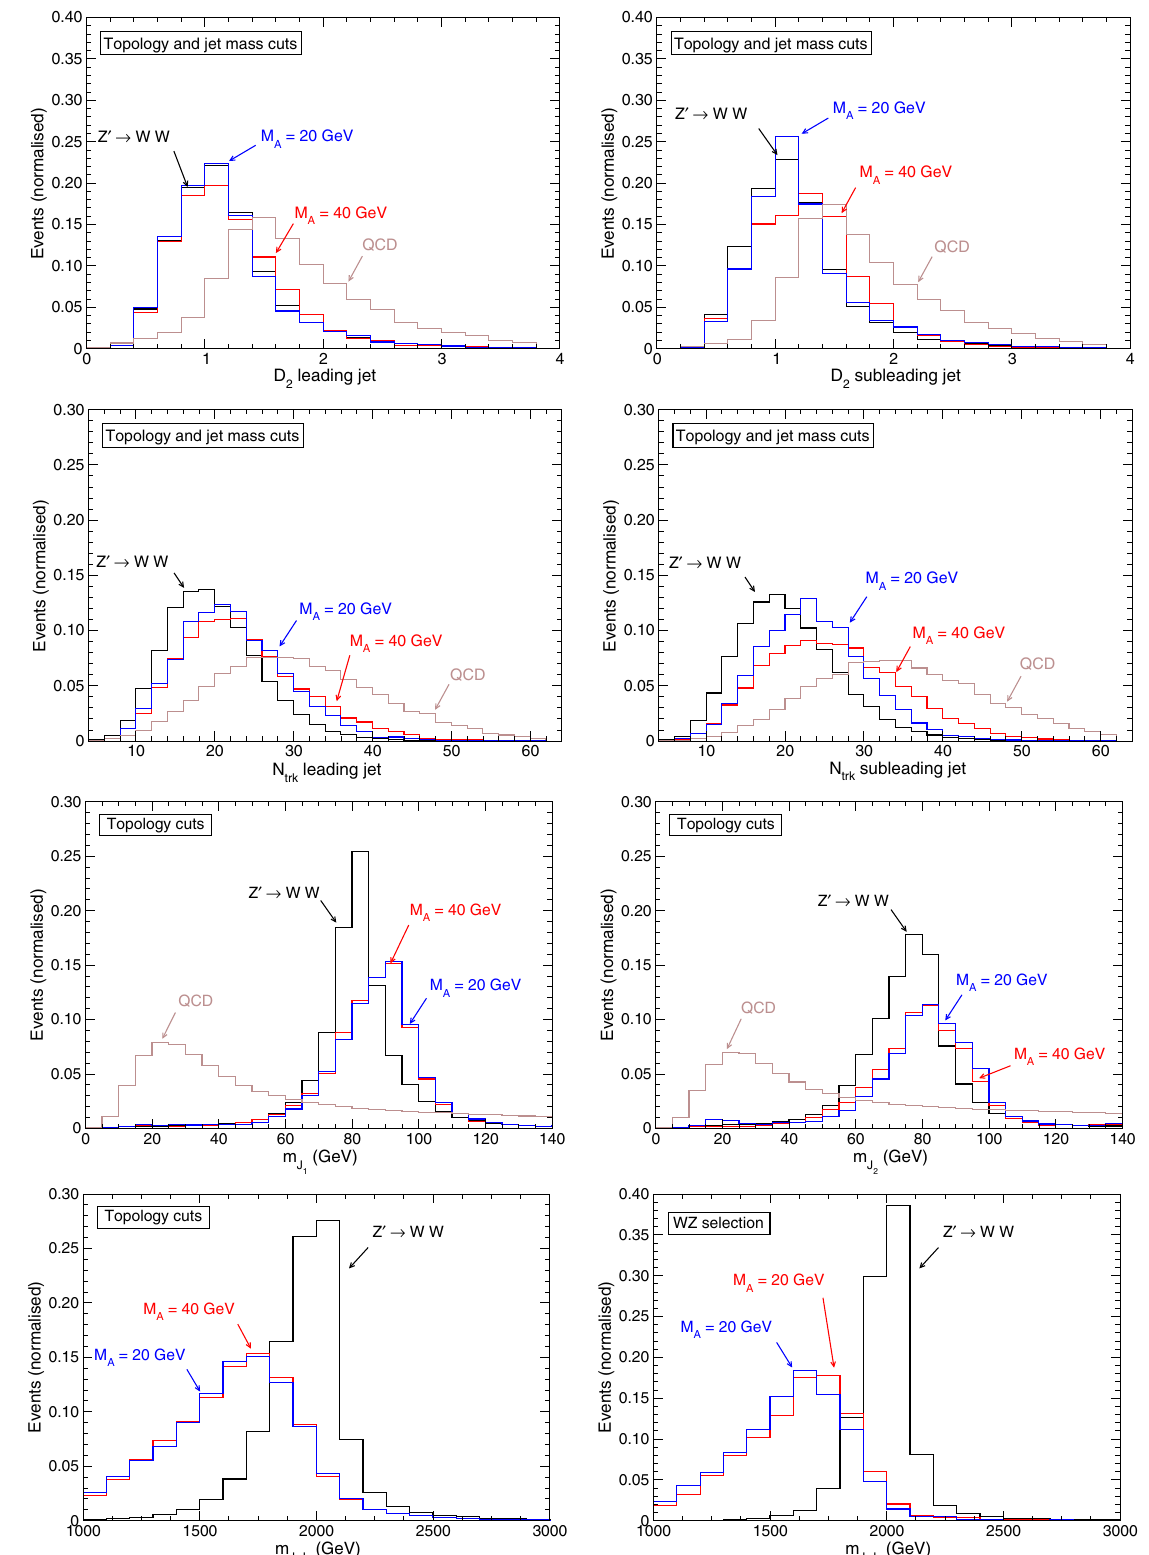
Fig. 13 Distributions for the R → V V S and Z (cid:8) → WW signals and the QCD dijet background in the ATLAS analysis. Top: D 2 variable; second row: number of tracks; third row: jet mass; bottom: dijet invariant